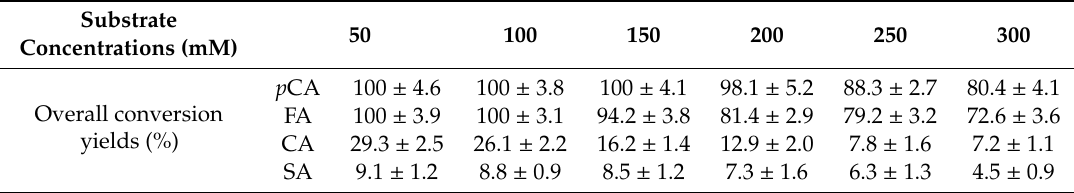
Table 1. Bioconversion of 4-hydroxycinnamic acid by Escherichia coli BL21 (DE3) cells carrying a pET22b-pelblpad vector after one hour of incubation. p CA: p -coumaric acid; CA: ca ff eic acid; and SA: